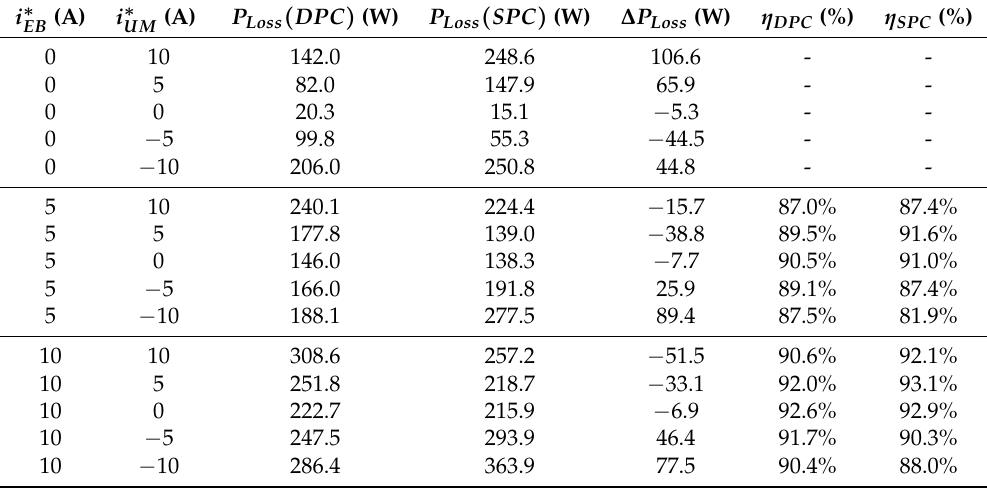
Table 5. Experimental losses and efficiency performance of SPC and DPC